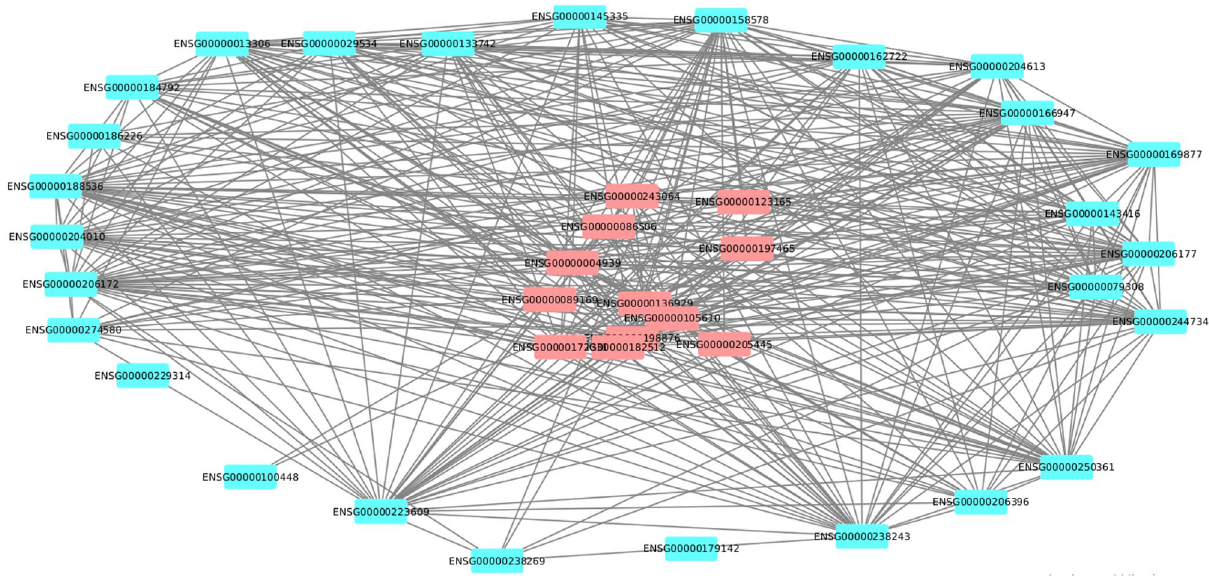
Figure 6. Likely differentially expressing genes (LDEGs) identified in Module 53 in extremely severe (ICU) vs severe COVID-19. LDEGs are represented in blue